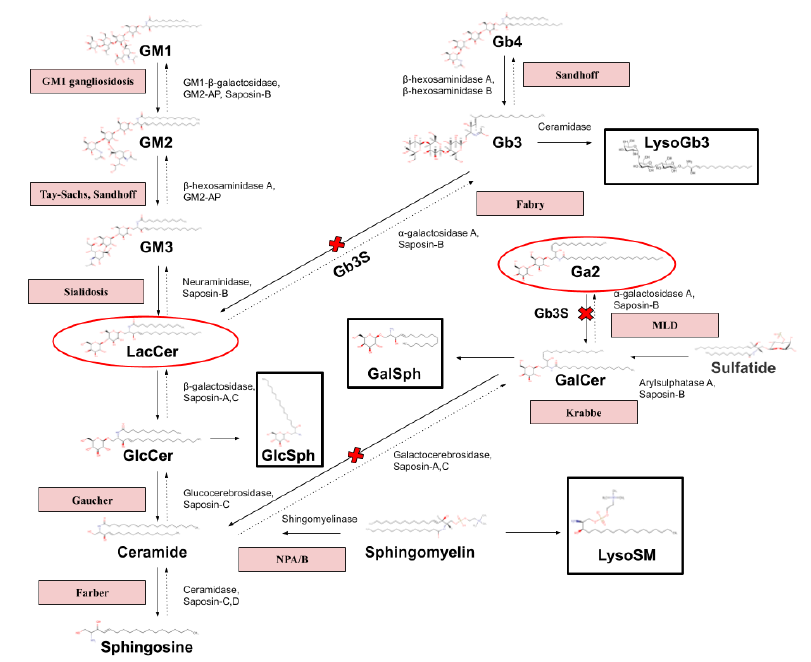
Figure 5. Pathway of sphingolipid degradation and related sphingolipidoses. (Miller et al [20] 2020; Heywood et al. [21] 2019). The diseases are indicated in the red boxes. Lysosphingolipids (LysoSLs) are indicated in the black boxes. The red ovals contain structural isomers. Gb4 — globotetraosylceramide; Gb3 — globotriaosylceramide; LysoGb3 — globotriaosylsphingosine; Ga2 — galabiosylceramide; GalCer — galactosylceramide; GalSph — galactosylsphingosine; LysoSM — lysosphingomyelin; GlcCer — glucosylceramide; LacCer — lactosylceramide; GM1, GM2, GM3 — gangliosides; and GlcSph — glucosylsphingosine.